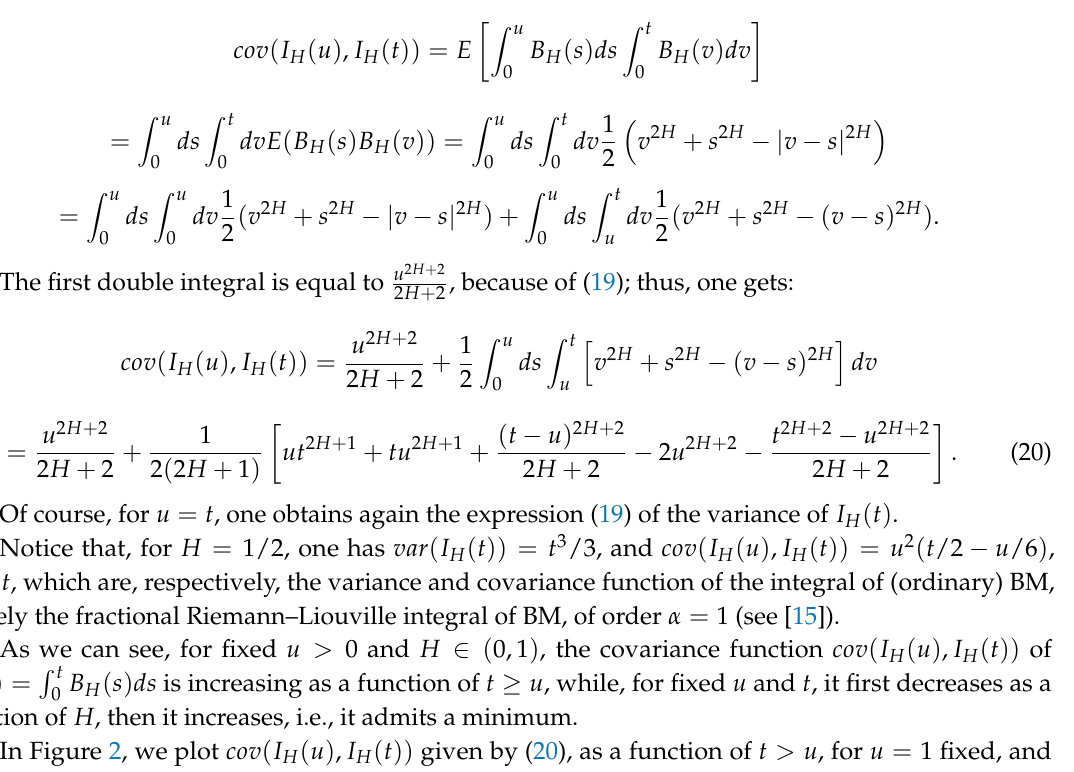
Figure 1. Plot of the variance of I H ( t ) = values of H ∈ ( 0,1 ) ; from bottom to top, with respect to the higher value at the right of t -axes, H = 0.05, 0.1, 0.2, 0.3, 0.4, 0.5, 0.8, 0.9, 0.99